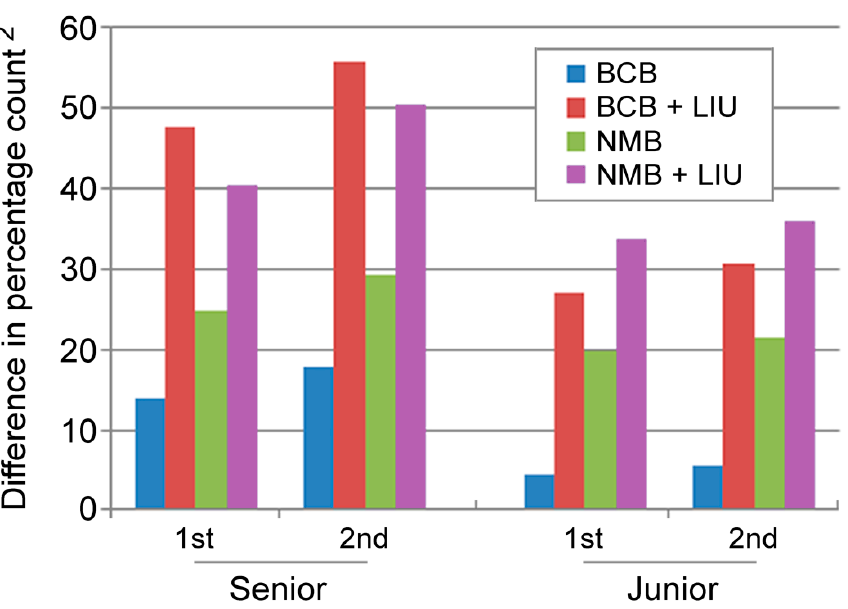
Figure 4. Variations in reticulocyte enumeration bias with staining method, observer, and repetition of counting. BCB—brilliant cresyl blue; NMB—new methylene blue; LIU—Liu ′ s stain.